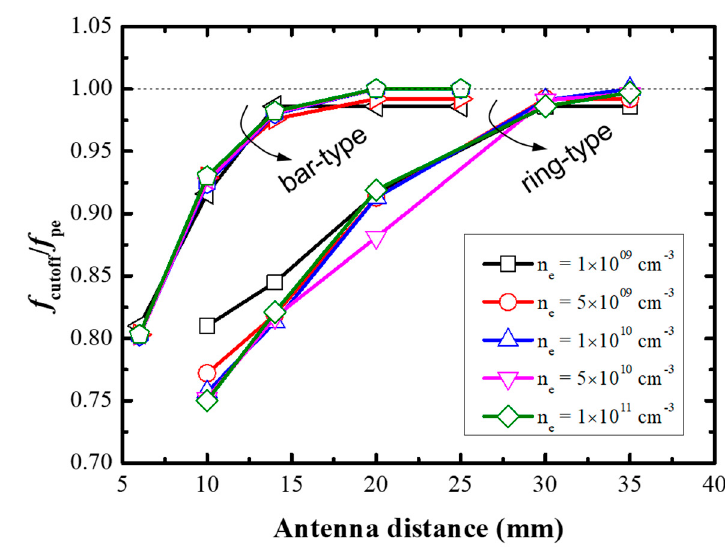
Figure 7. Normalized cutoff frequency (f cutoff /f pe ) of the RCP and BCP with various antenna distances and input electron densities at a = e = 2.0 mm and p = 100 mTorr.